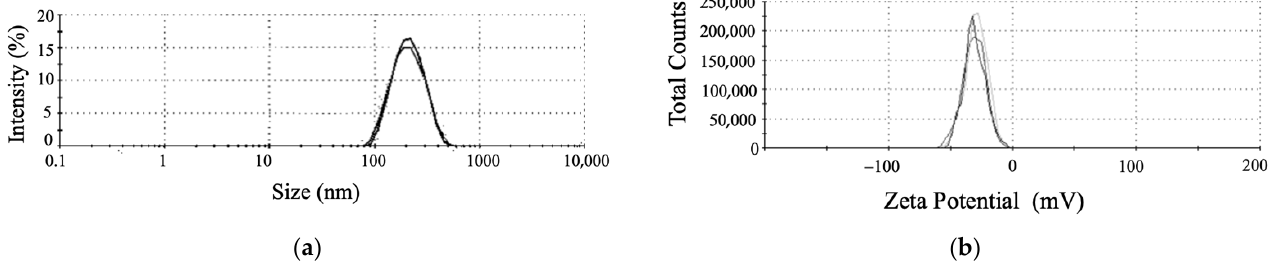
Figure 4. The characteristics of SeNPs produced by B. subtilis T5. ( a ) Particle size distribution; ( b ) Zeta Potential.